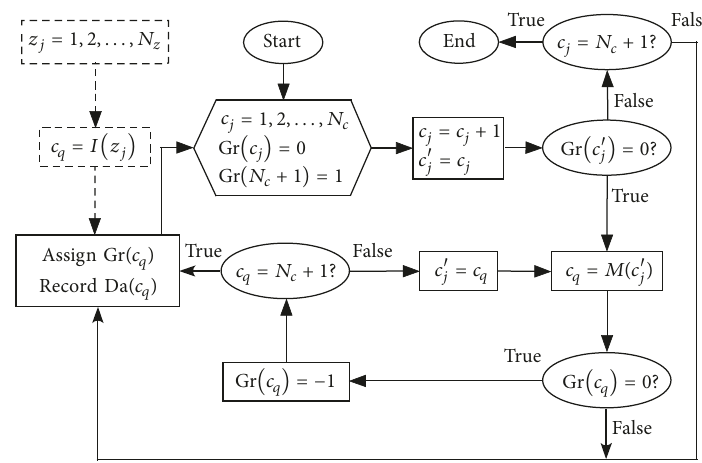
Figure 3: Flow chart of the cell mapping